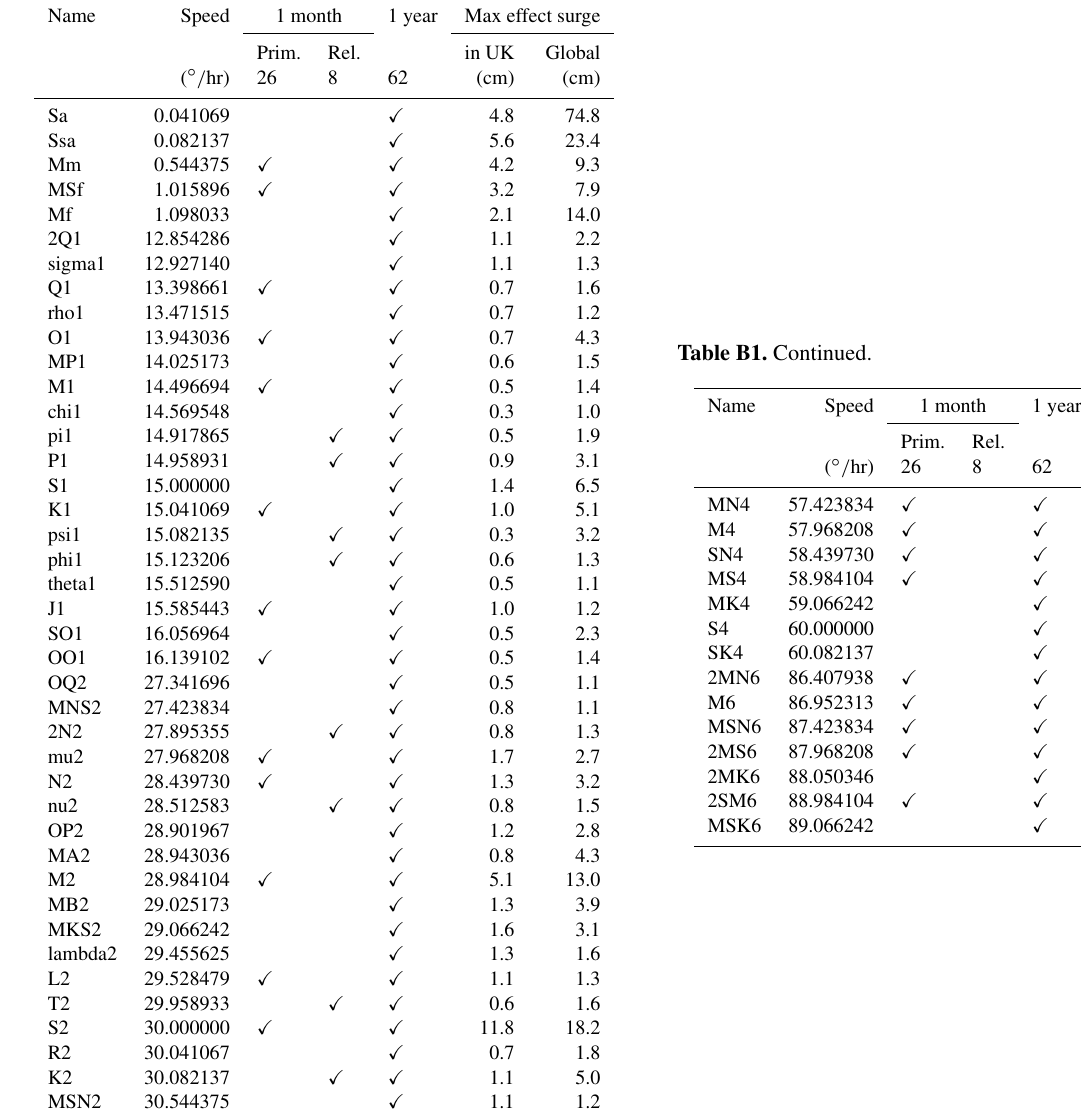
Table B1. Tidal harmonic constituents referred to in this paper and the maximum change constituents fitted to GTSM tide only ( M t ) or with tide-and-surge forcing ( M s ) at coastal locations, as from Fig.